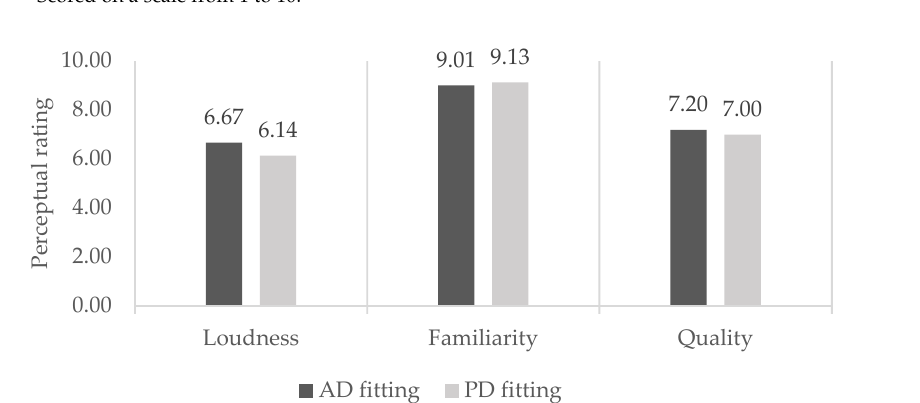
Figure 2. A visual representation of the perceptual ratings of audio samples at PD and AD settings (Mean values).